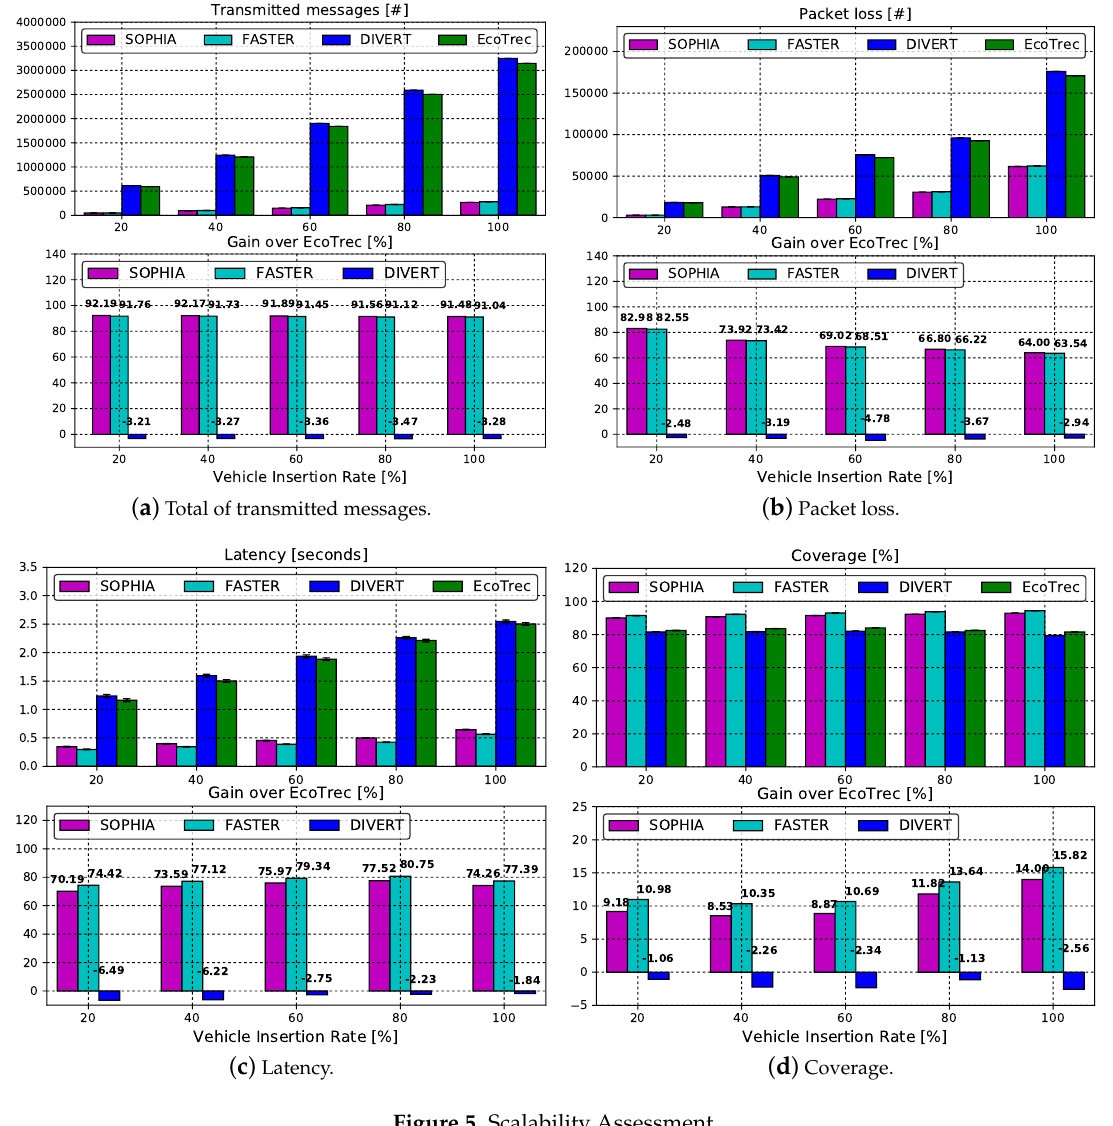
Figure 5. Scalability